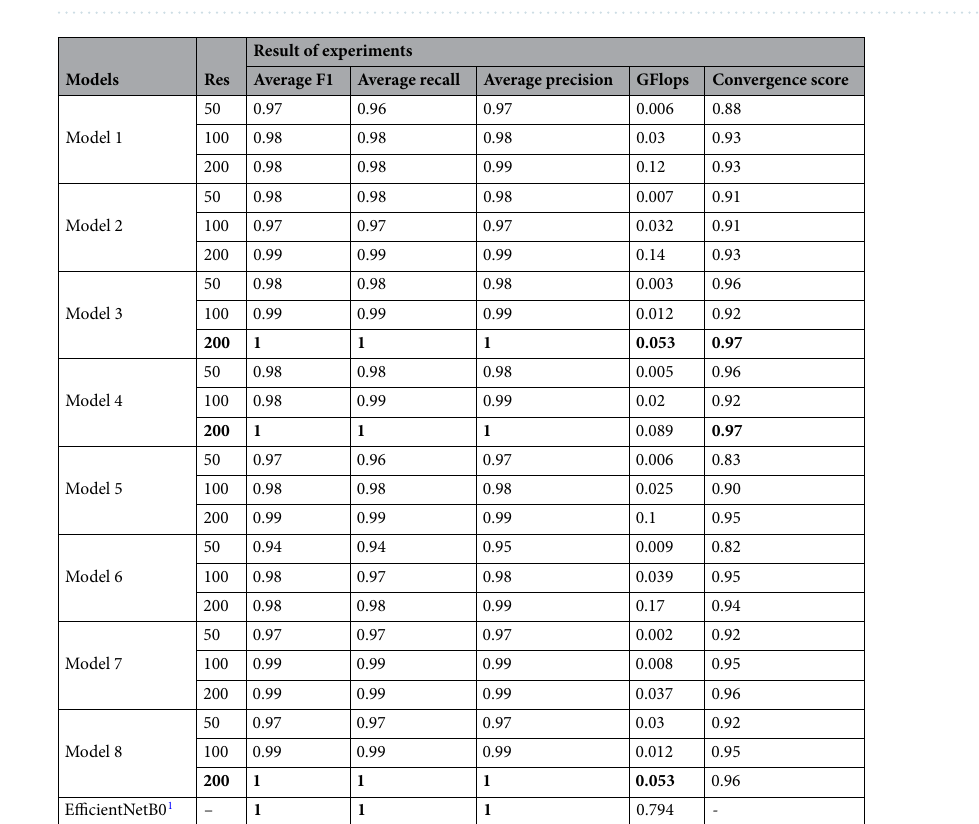
Figure 5. Accuracy of the models during training on validation set.